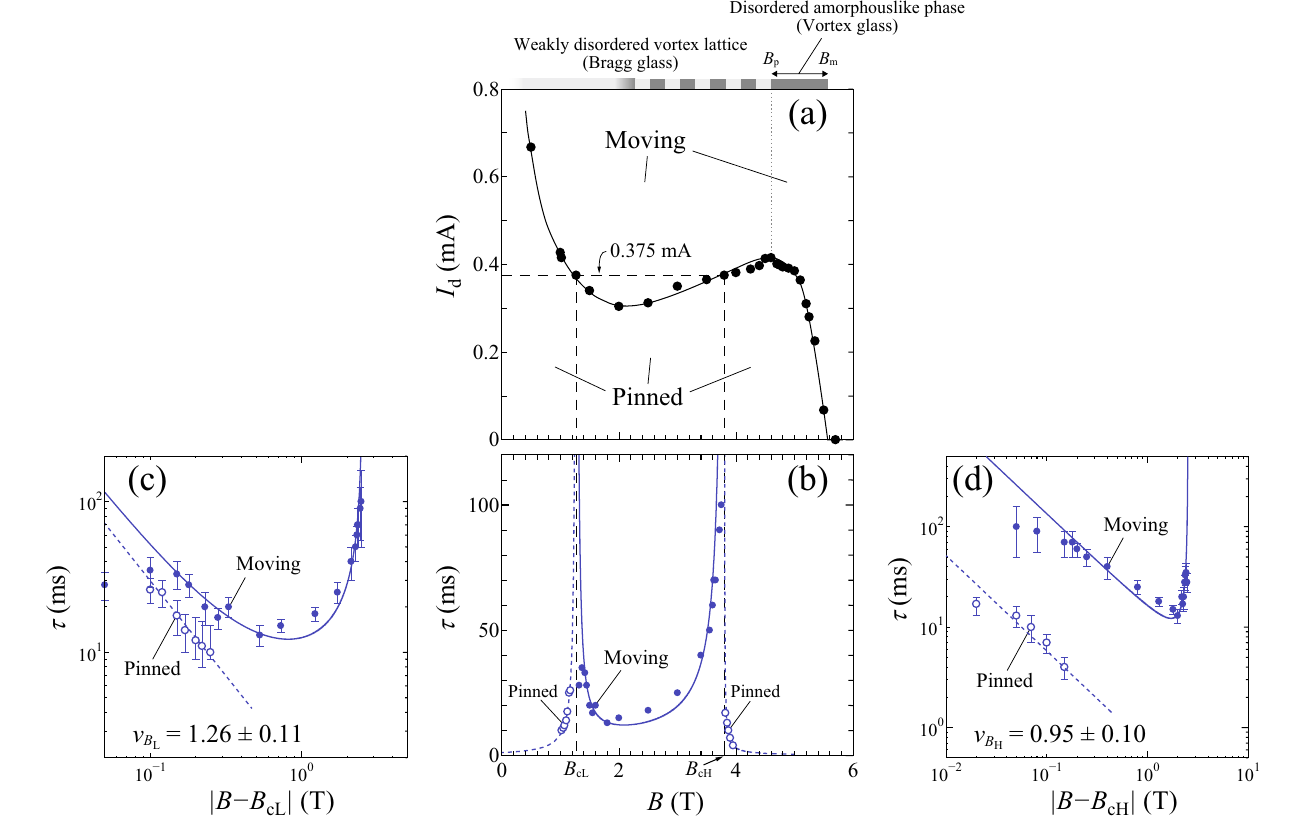
Figure 2. The critical divergence of the relaxation time τ( B ) at the density-driven depinning transition ( B cL ) and repinning transition ( B cH ). ( a ) The B dependence of I d at 4.1 K, where a full line is a guide to the eye. I d ( B ) corresponds to the transition line separating the pinned phase ( < I d ( B ) ) from the moving phase B cL ) and 3.8 T( B cH ) indicated with vertical dashed lines give the same I d ( > I d ( B ) ). B 1.27 T( 0.375 ≡ ≡ = = mA marked with a horizontal dashed line. ( b ) τ measured under constant I = 0.375 mA for B < 1.27 T and B > 3.8 T (open blue circles) and for 1.27 < B < 3.8 T (solid blue circles) plotted against B , showing the power-law divergence on both sides of the two threshold fields; B cL 1.27 T and B cH 3.8 T, as indicated with vertical = = B B cL B B cH dashed lines. ( c ) log τ versus log and ( d ) log τ versus log , where the symbols are the same | − | | − | as in ( b ). All the data below 3.8 T and above 1.27 T are plotted in ( c ) and ( d ), respectively. The blue dotted ν BL with ν B B cL line in ( c ) and that for B < B cL in ( b ) represent the power-law fits by τ B L = 1.26 ± ∝ | − | − 0.11. The blue dotted line in ( d ) and that for B > B cH in ( b ) indicate the power-law fits by τ